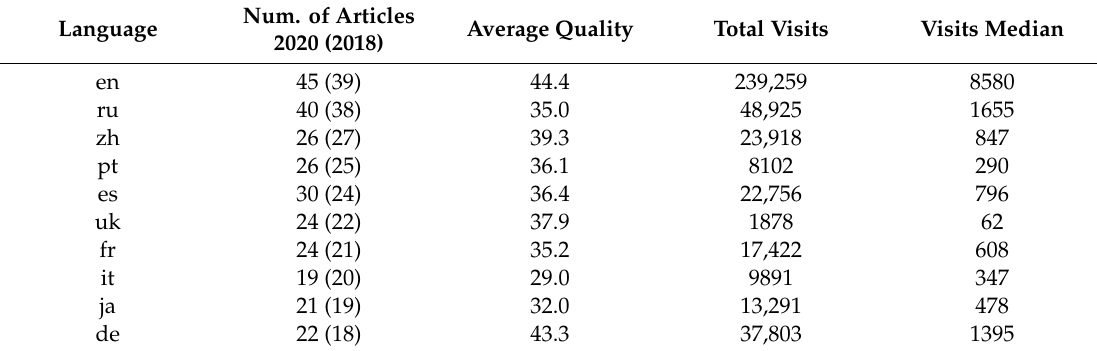
Table 11. Basic facts about cryptocurrencies description in Wikipedia language